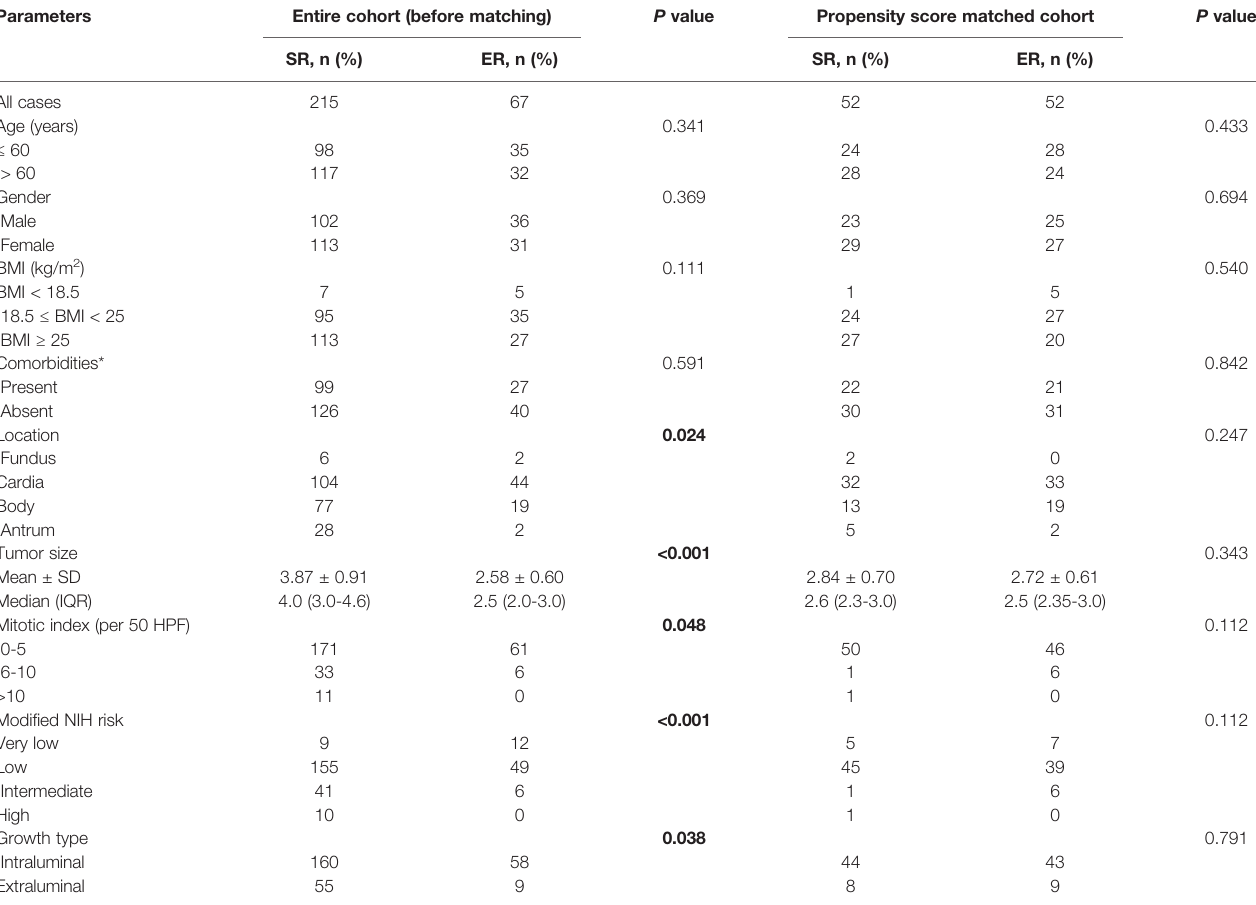
TABLE 1 | Baseline clinicopathologic characteristics of SR and ER group in the entire cohort and after propensity score matching. Parameters Entire cohort (before matching) P